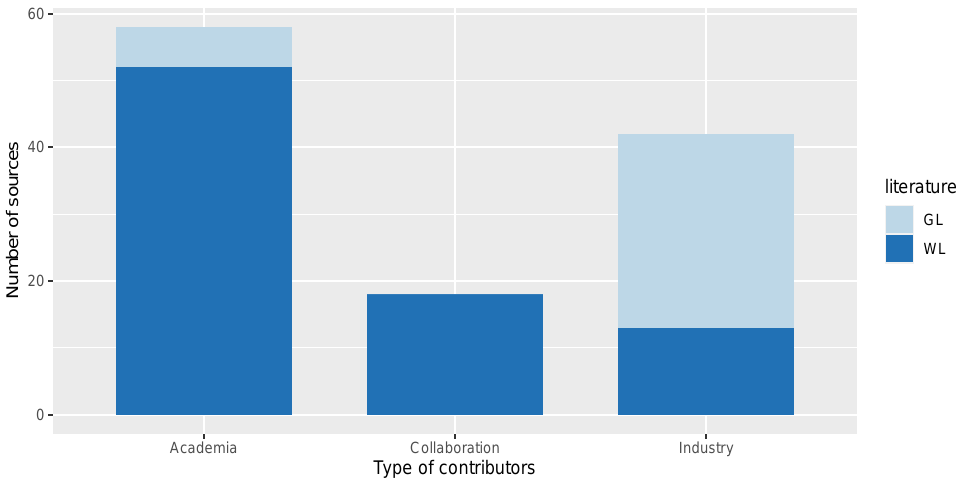
Figure 5. Number of sources by types of